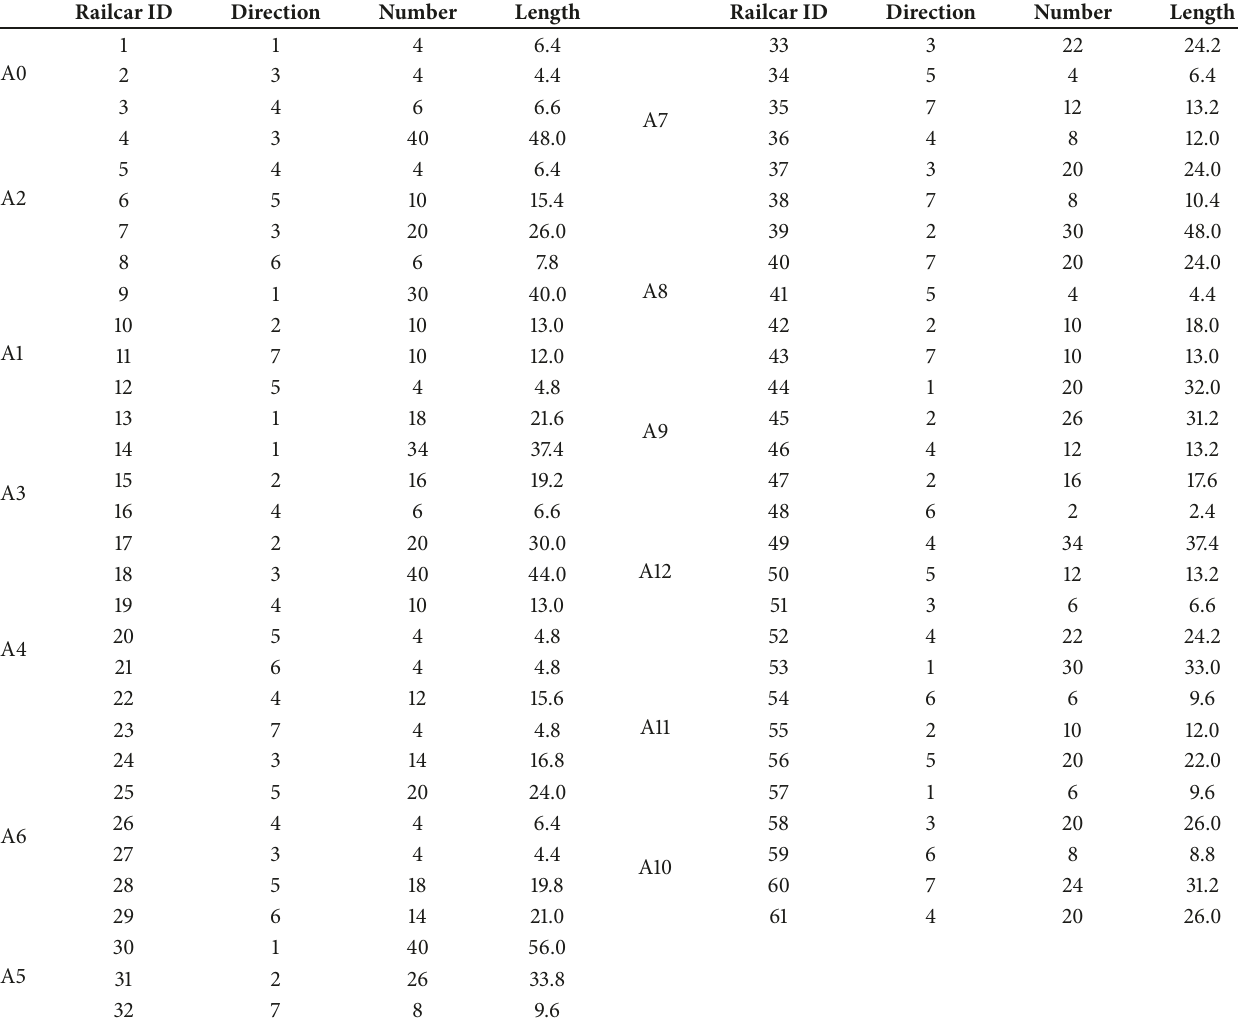
Table 3: Railcars information of inbound